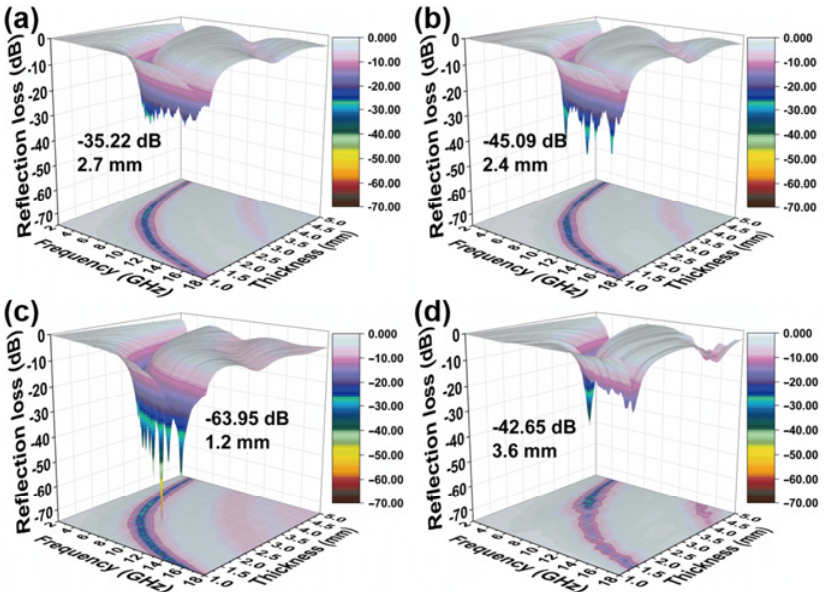
Fig. 6 3D RL curves and contour mappings of (a) 2D Ti 3 C 2 T x @CoNi nanosheets and (b–d) SiO 2 @Ti 3 C 2 T x @CoNi microspheres with CoNi alloy of different thicknesses ( T CoNi = 110, 250, and 400 nm).